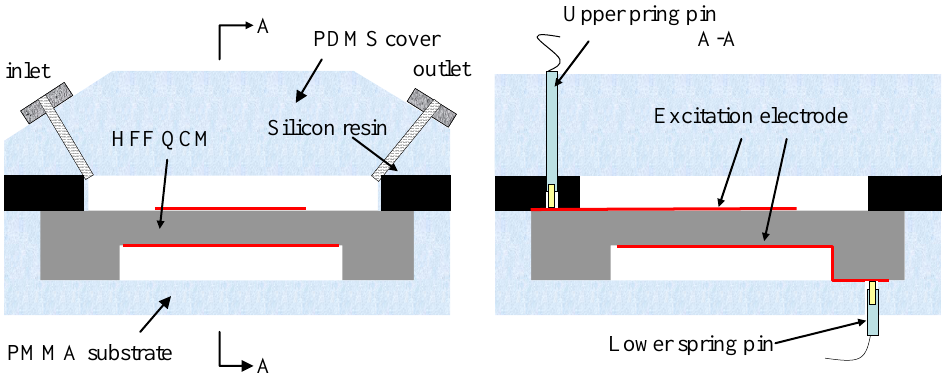
Figure 4. Schematic diagram of the flow